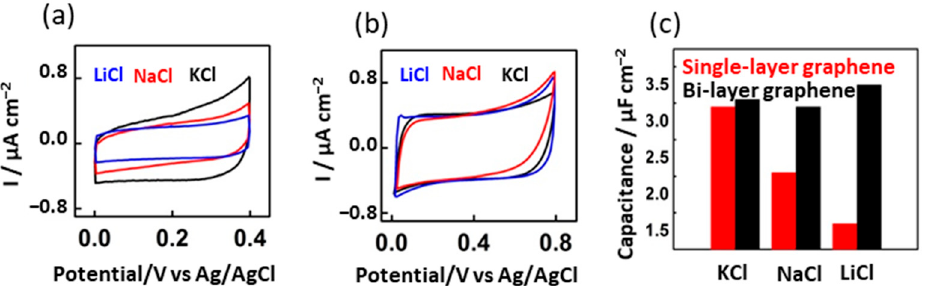
Figure 2. Cyclic voltammograms of LiCl (blue), NaCl (red), and KCl (black) aqueous solutions on ( a ) single-layer graphene and ( b ) bilayer graphene electrodes. ( c ) Capacitances of KCl, NaCl, and LiCl aqueous solutions on single-layer (red) and bilayer graphene (black) [33]. Copyright © 2020, American Chemical Society.